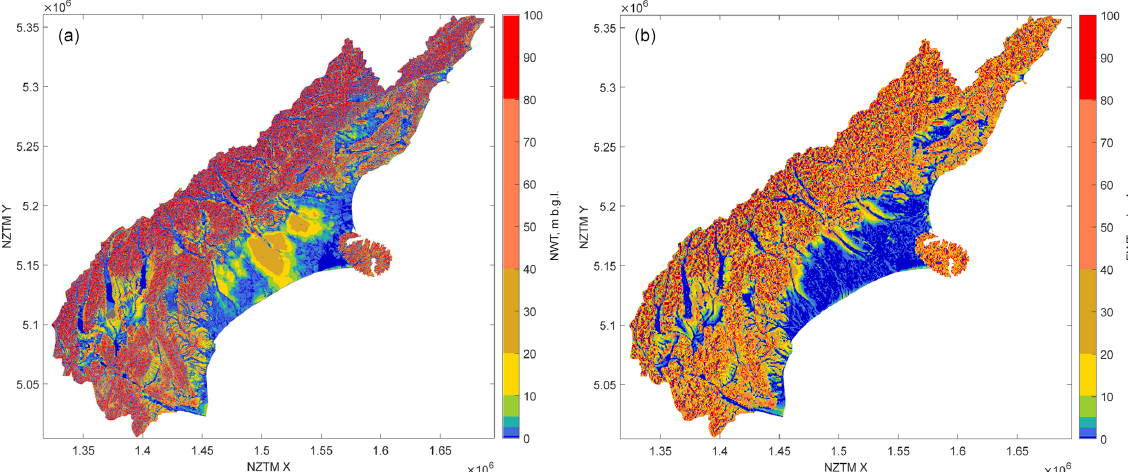
Figure 9. Water table depth of the (a) NWT and (b) EWT models in the Canterbury region.